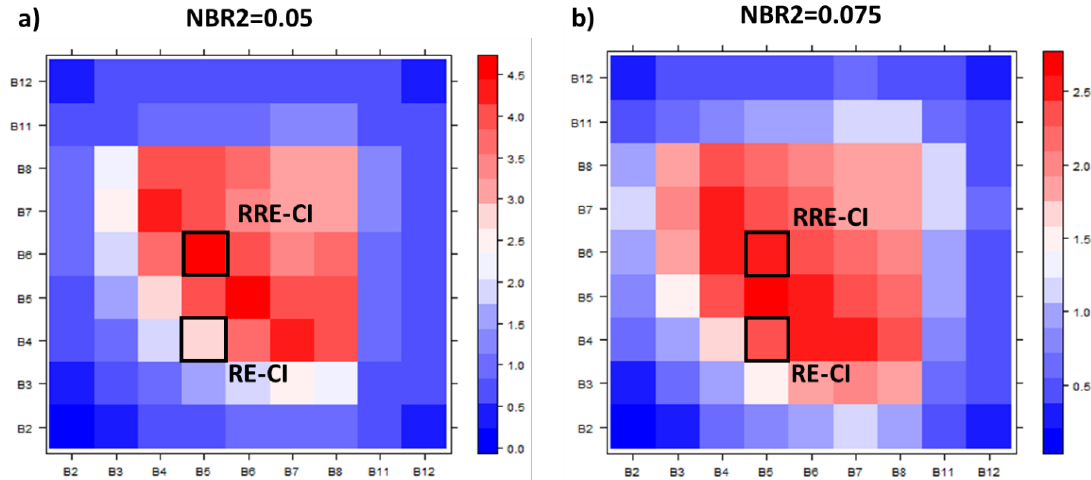
Figure 11. Ratio of performance to deviation (RPD) of validation using a Normalized Burn Ratio 2 (NBR2) index thresholds of 0.05 ( a ) and 0.075 ( b ). The black squares highlight the Red-Red edge carbon index (RRE-CI) and the Red edge carbon index (RE-CI).